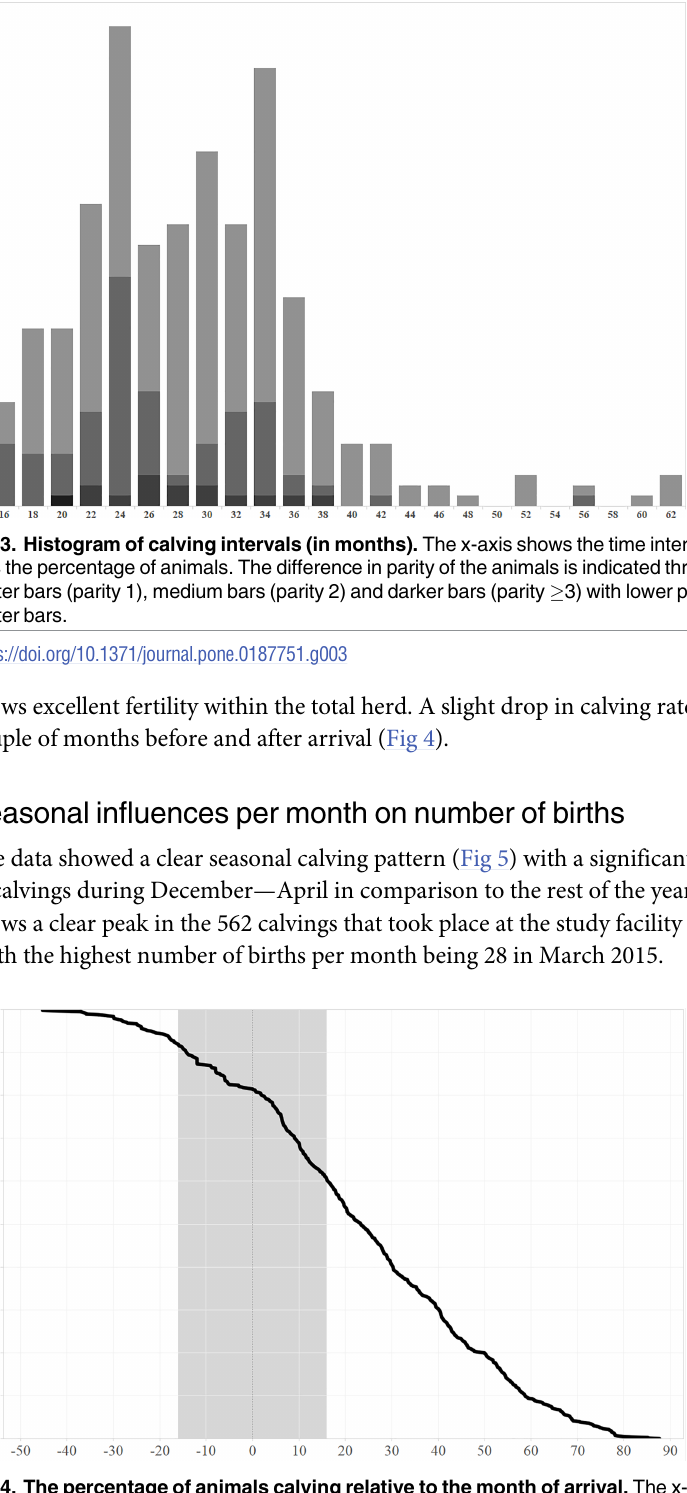
Fig 4. The percentage of animals calving relative to the month of arrival. The x- axis shows the time in months before and after the moment of arrival at the facility. The y-axis indicatesthe remainingpopulation percentage to calve throughoutthe study period. The vertical grey bandwidthindicatesthe ± 16months pre and post arrival interval.